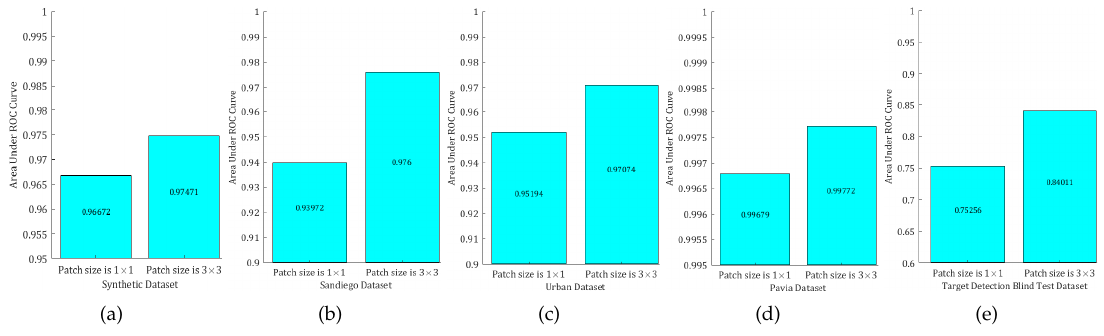
Figure 27. Without patch-based and patch-based AUC values. ( a ) Synthetic Dataset; ( b ) San Diego Dataset; ( c ) Urban Dataset; ( d ) Pavia Dataset; ( e ) Target Detection Blind Test